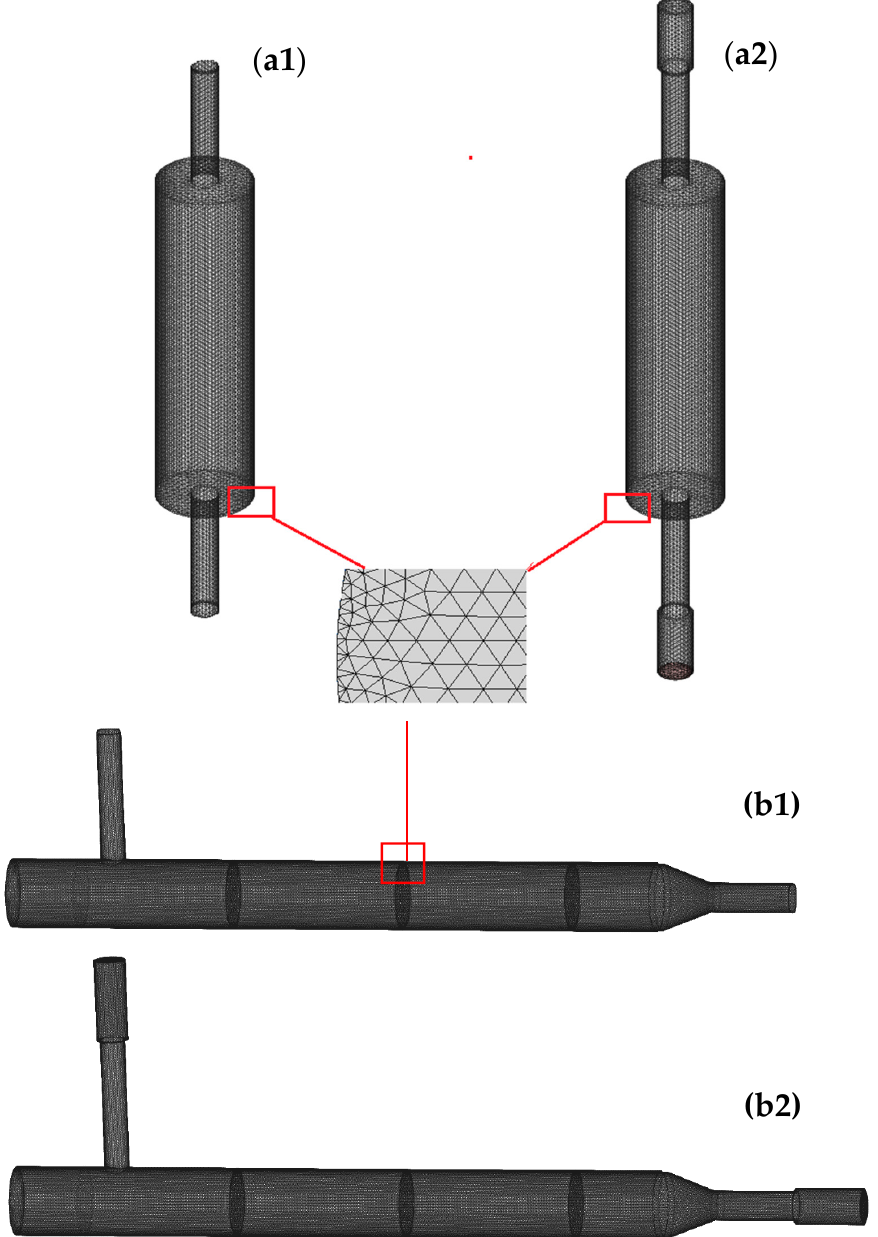
Figure 9. Discretized expansion chamber ( a1 ) without and ( a2 ) with the pipe discontinuity and model-scale scrubber ( b1 ) without and ( b2 ) with the pipe discontinuity.